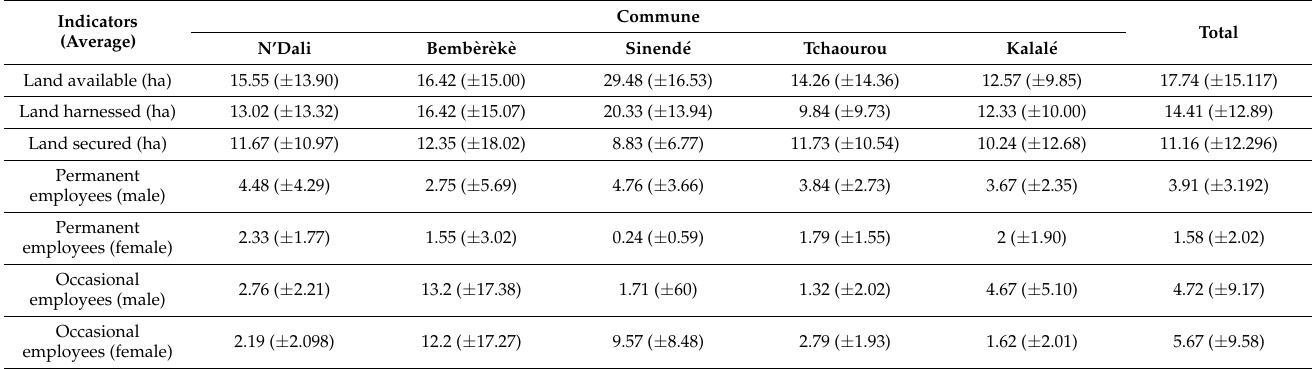
Table 5. Average land area and number of